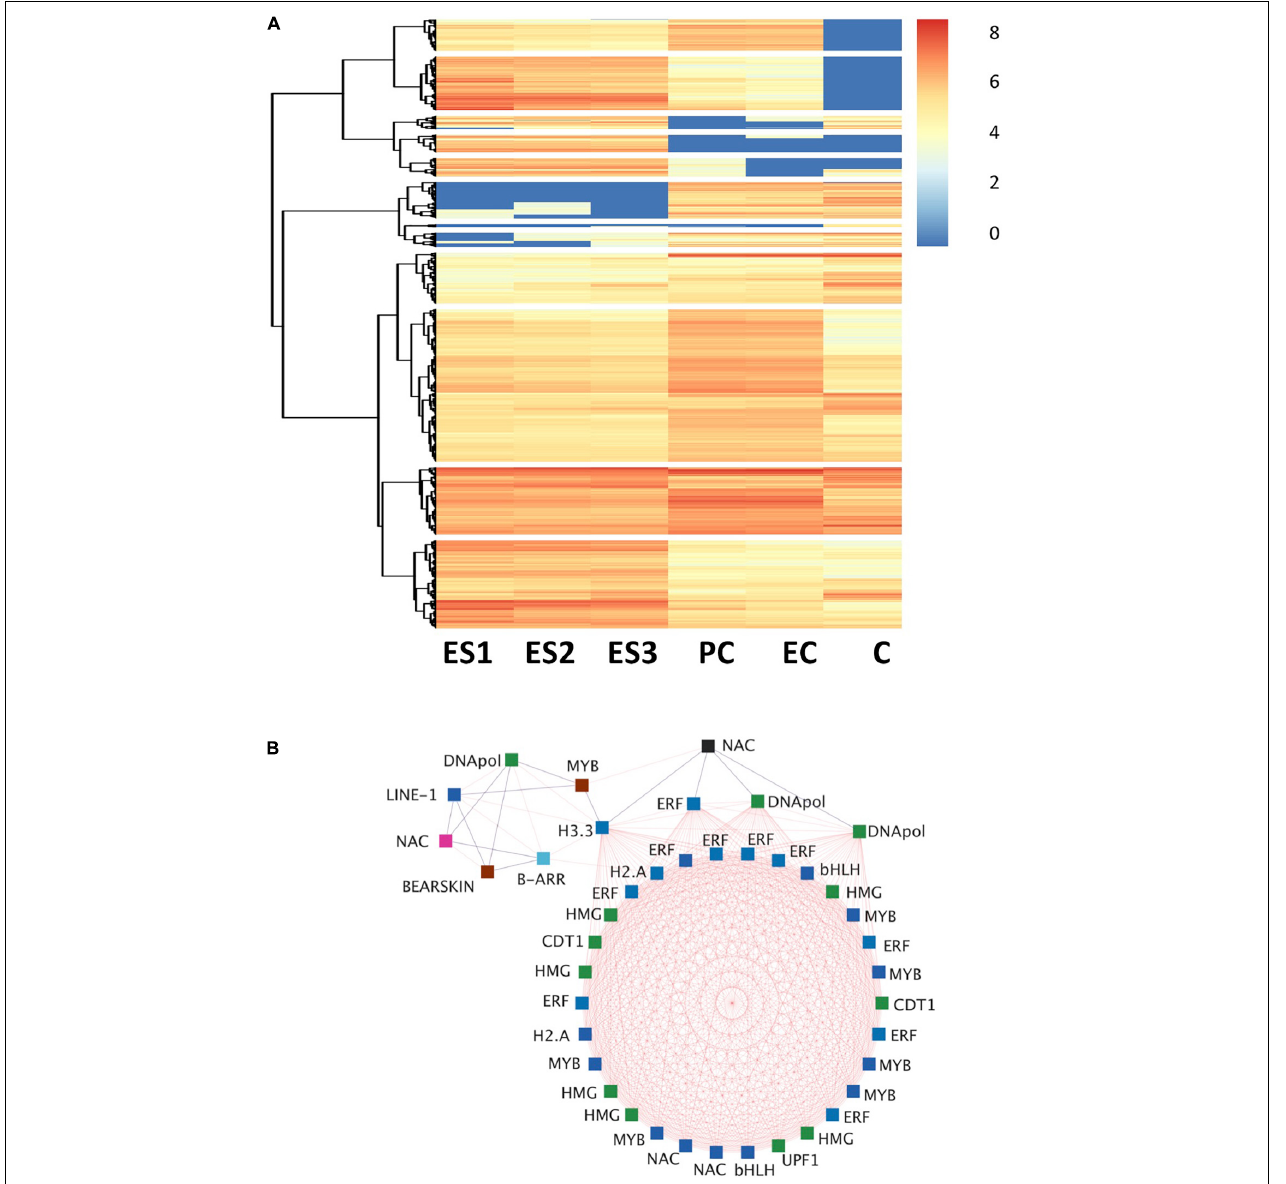
FIGURE 4 | Identification of hub genes and transcription factors. (A) Hierarchical clustering and heat map of hub genes differentially expressed in somatic: ES1, ES2, and ES3 and zygotic: PC, EC, and C embryos. The heat map represents a total number of 1657 hub genes with connectivity > 10% (see section “Materials and Methods”). The hierarchical clustering was performed using Ward’s minimum variance method. (B) Co-expression network interactions of TF hub genes differentially expressed during pine embryo development. TFs included are: NAC domain protein (NAC), Myb-related protein (MYB), ethylene-responsive TF (ERF), protein BEARSKIN, high mobility group B protein (HMG), histone H3.3, histone H2A, chromatin licensing and DNA replication factor 1 (CDT1), DNA polymerase (DNApol), regulator of nonsense transcripts 1-like protein (UPF1), bHLH, LINE-1 reverse transcriptase isogeny (LINE-1) and type-B response regulator (B-ARR). Cytoscape version 3.9.1 platform was used to visualize the network (Shannon et al., 2003). Square symbols mean TF, blue edges indicate negative co-expression associations and red edges indicate positive co-expression associations. Colors inside each symbol agree with the co-expression module where the gene is included